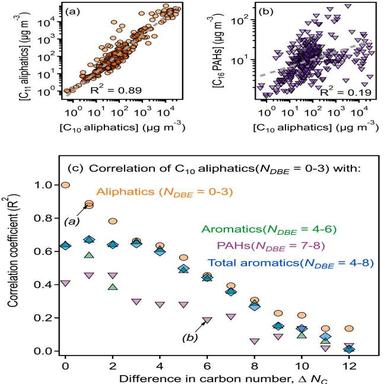
Correlation of log-transformed measured concentrations of C10 aliphatic hydrocarbons to (a) C11 aliphatic hydrocarbons and (b) C16 PAHs. (c) Correlation coefficient, R2 , for correlation of C10 aliphatic hydrocarbons to all compound classes as a function of carbon number difference, with colors and shapes indicating broad structural class designations (For interpretation of the references to colour in this figure legend, the reader is referred to the web version of this article).